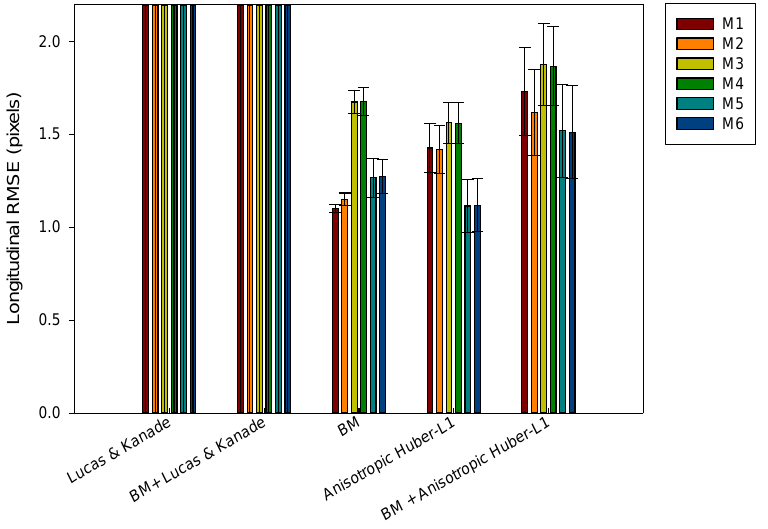
Figure 6. Longitudinal error results after being evaluated with different